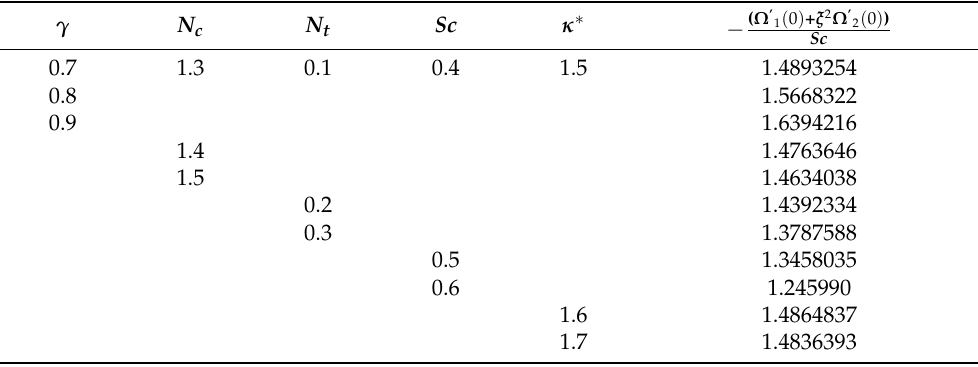
Table 3. Numerical estimation of local Stanton number ( St r R ex 1 2 ) for different parameters γ , N c , N t , Sc , k ∗ .